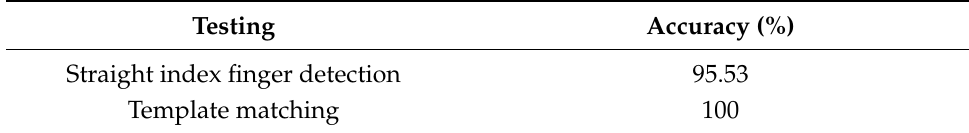
Table 2. Hand pointing determination